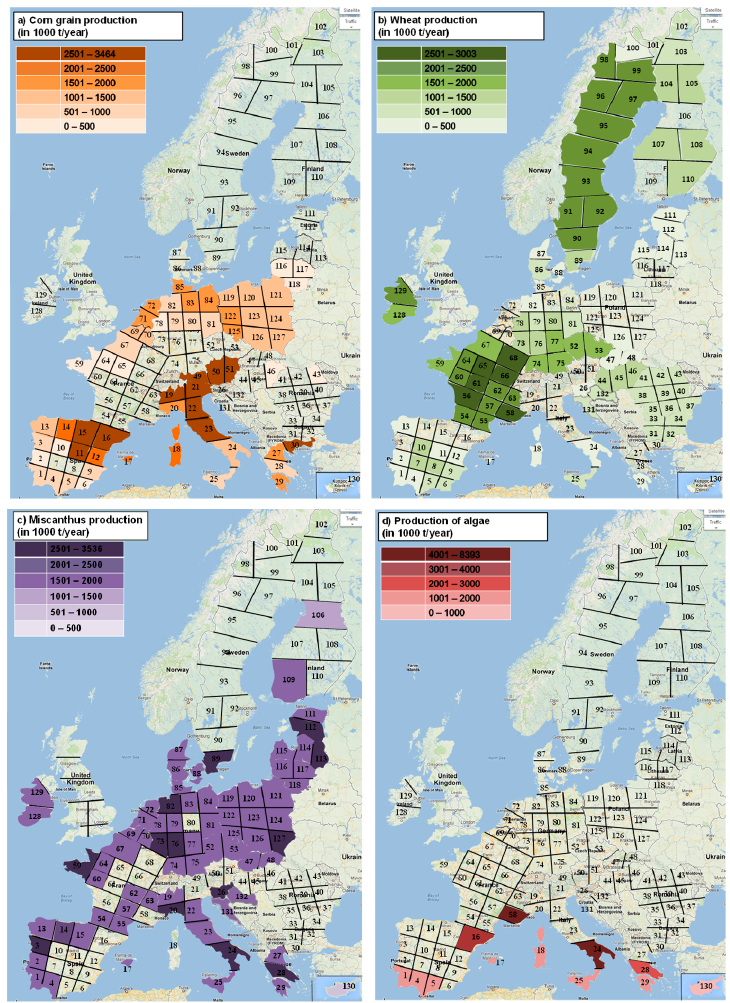
Figure 5. Production of ( a ) corn grain, ( b ) wheat, ( c ) algae, and ( d ) miscanthus when maximizing sustainability profit.